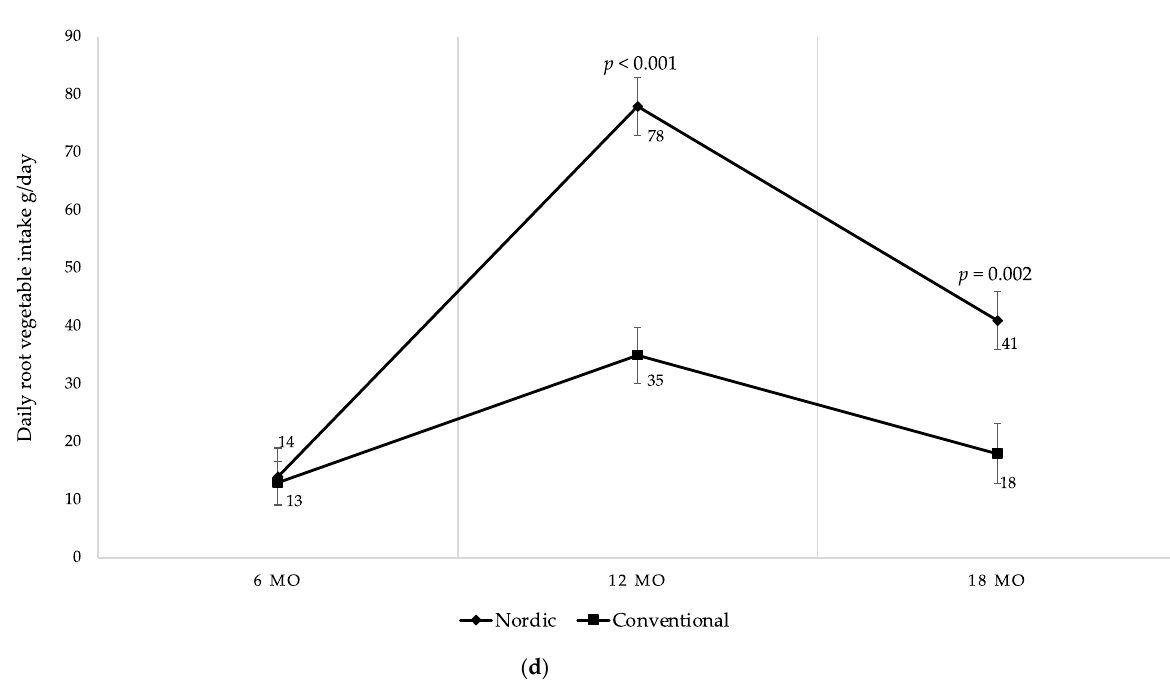
Figure 5. ( a ) Mean daily fruit and vegetable intake (g/day) at 6, 12 and 18 mo of age; ( b ) mean daily fruit intake (g/day) at 6, 12 and 18 mo of age; ( c ) mean daily vegetable intake (g/day) at 6, 12 and 18 mo of age; ( d ) mean daily root vegetable intake (g/day) at 6, 12 and 18 mo of age. Fruit juices, vegetable juices, potatoes, chili, garlic, ginger and herbs are not included in the calculations. Whiskers indicate 95% confidence intervals. p -values indicate between group differences. Table 5. Daily intake of berries and exotic fruits at the 12 and 18 mo 5-day dietary registrations.